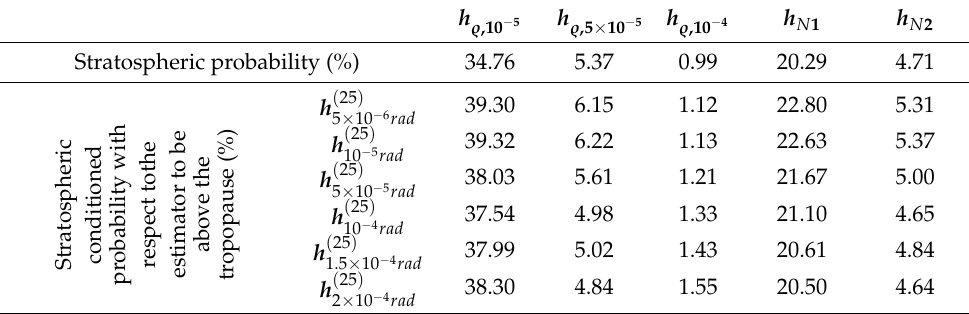
(25) to be in the stratosphere as 𝑖 ( 25 ) γ i to be in the stratosphere as